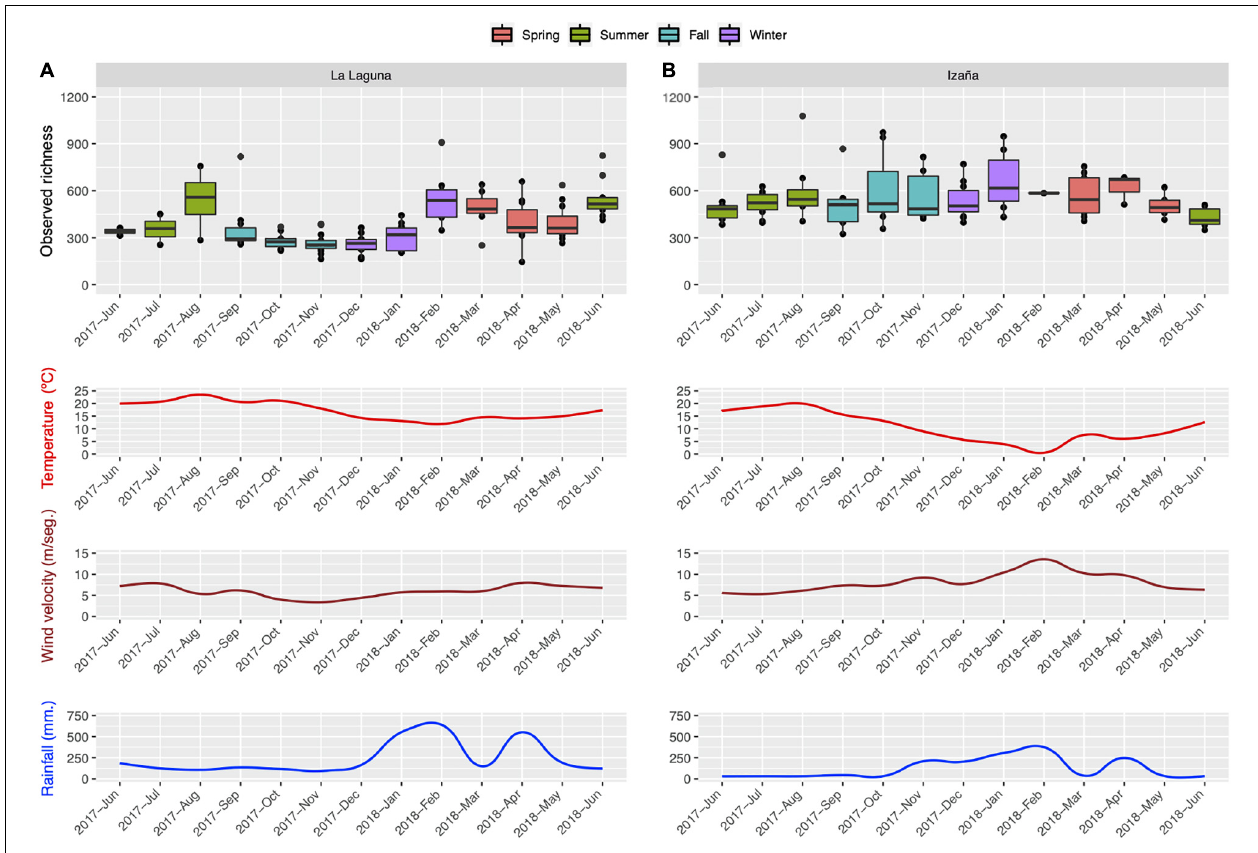
FIGURE 4 | Monthly distribution of observed richness by sampling location, La Laguna (A) and Izaña (B) , along with monthly average values of temperature and wind speed, and monthly accumulated rainfall.